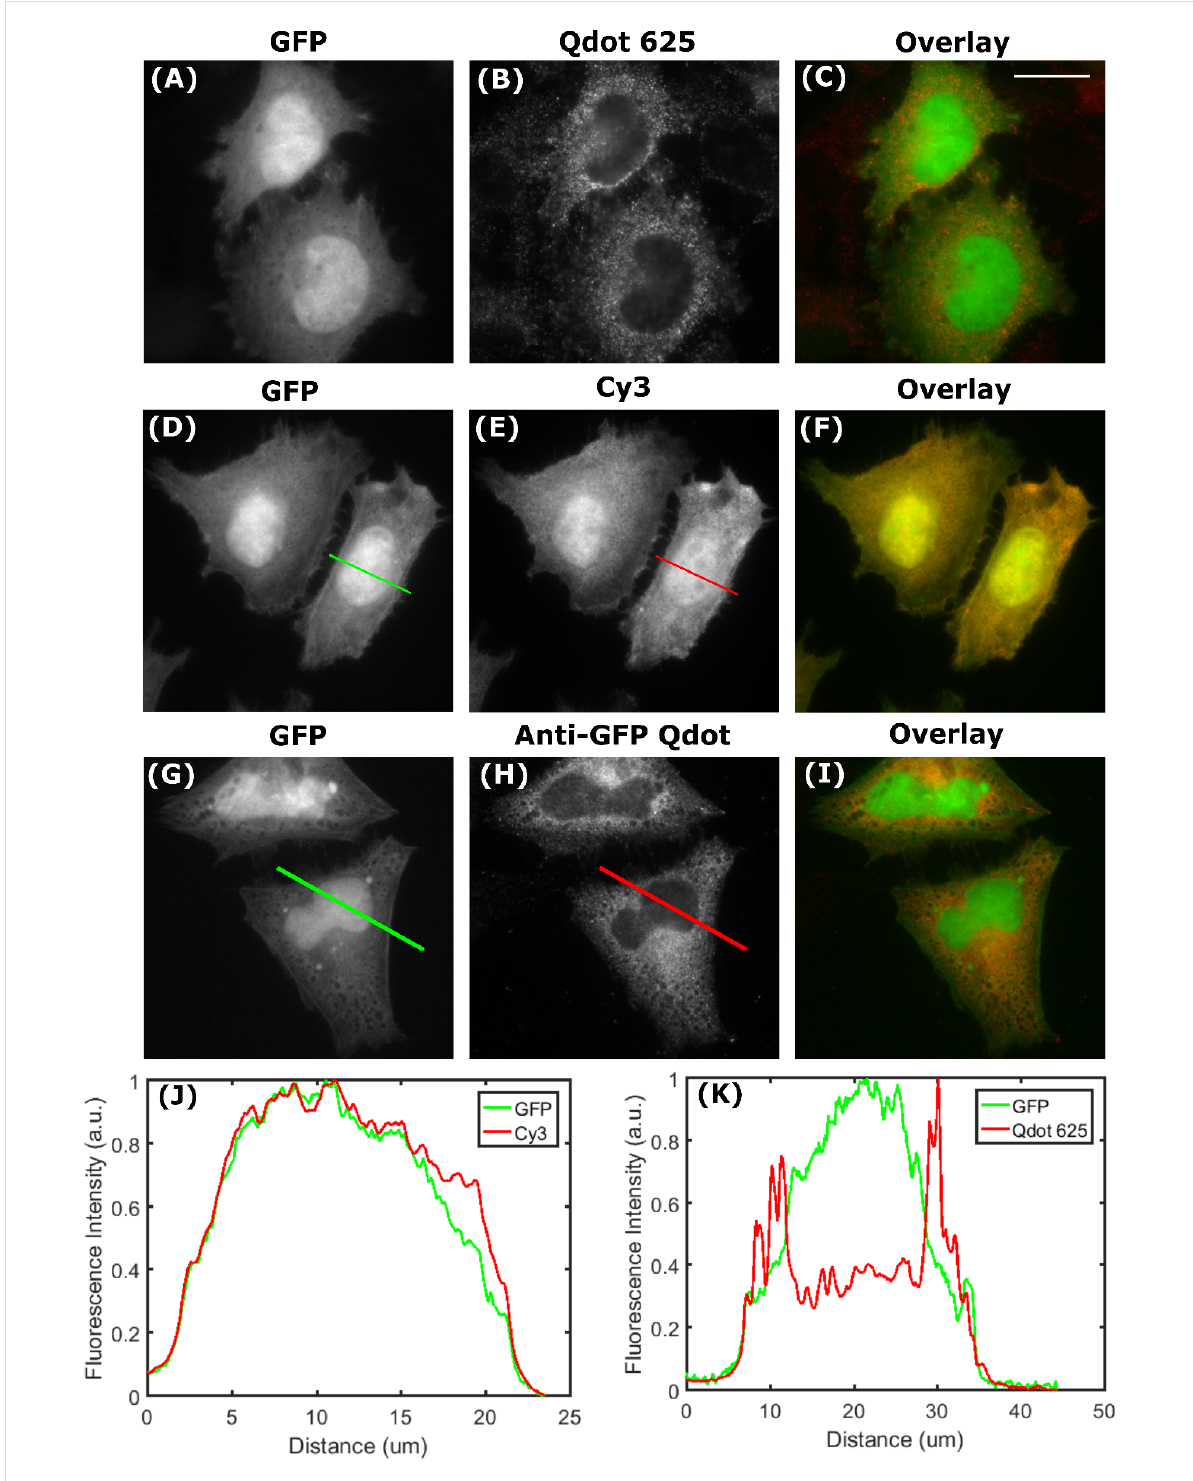
Figure 7: Qdot-Abs are unable to access the cell nucleus. Fixed HeLa cells were transfected with unconjugated soluble GFP (A), incubated with a pri- mary anti-GFP antibody, and red Qdot-Ab (B) to produce an overlaid image (C). Fixed HeLa cells were also transfected with unconjugated soluble GFP (D), incubated with a primary anti-GFP antibody, and red cyanine 3 conjugated to a secondary antibody (E) to produce an overlaid image (F). Direct ICC was done by incubating fixed HeLa cells, transfected with unconjugated soluble GFP (G), with an anti-GFP Qdot 625 conjugate (H) to produce an overlaid image (I). Normalised fluorescence intensities of unconjugated soluble GFP labelled with Cy3 (J) and Qdot 625 (K) were plotted from corresponding lines scans to show no labelling within the nucleus with Qdot 625. Scale bar is 20 μ